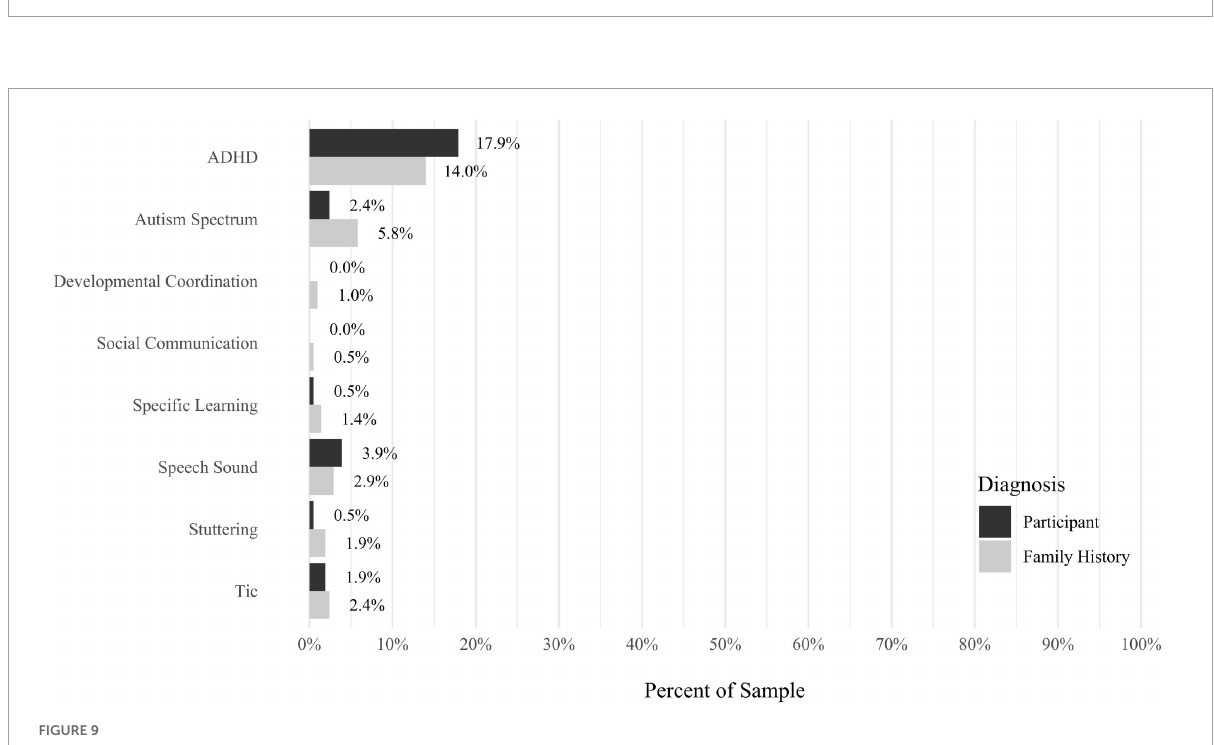
FIGURE9 Rates of medical health problems: neurodevelopmental